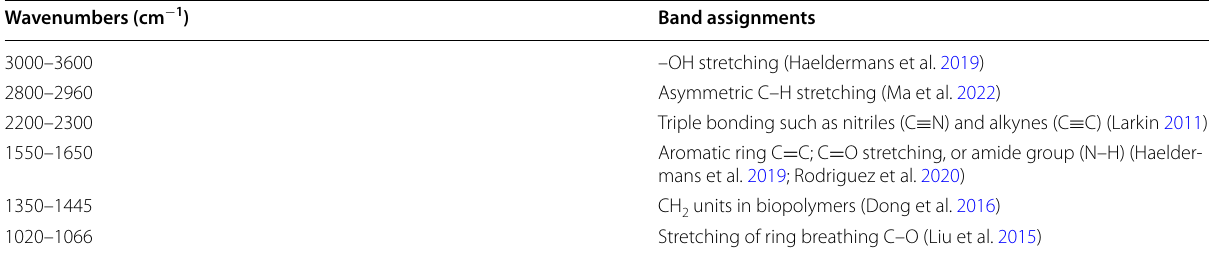
Table 2 FTIR spectra and their corresponding functional group Wavenumbers (cm − 1